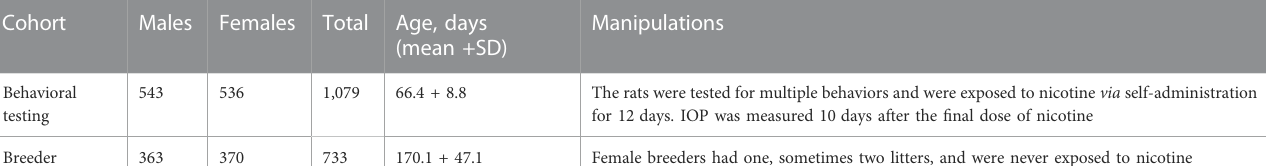
TABLE 1 Description of two cohorts of HS rats used to measure IOP. Cohort